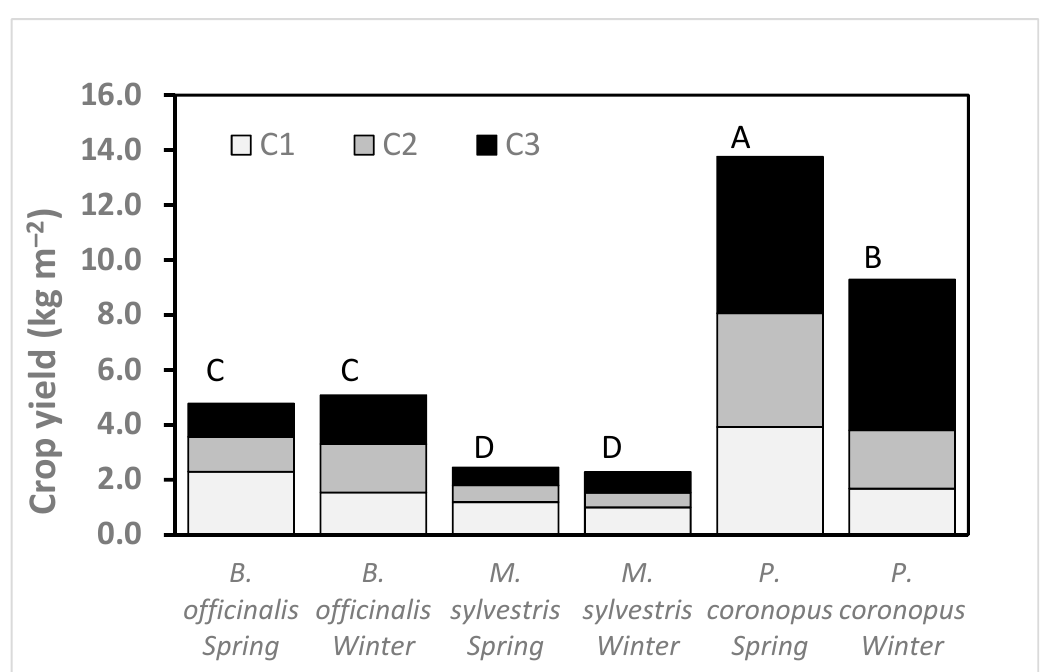
Figure 1. Crop yield (fresh leaves) of Borago officinalis, Malva sylvestris and Plantago coronopus hydro- ponically grown under greenhouse in winter or in spring and subjected to three consecutive cuts (C1, C2, C3). Data keyed with different letters are significantly different for p < 0.05 following two-way ANOVA and Tukey’s HSD post-hoc test for the effect of plant species and growing season. Values are the mean (±S.E.) of three replicates.